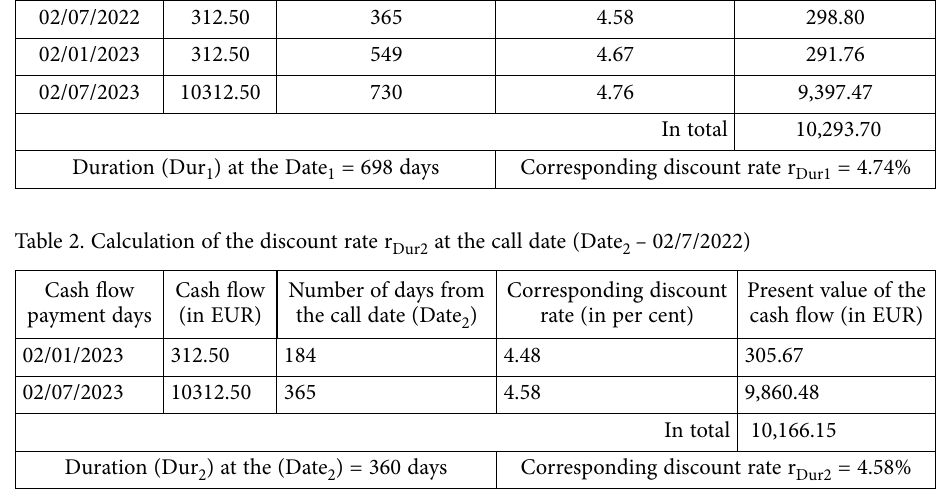
Table 1. Calculation of the discount rate r Dur1 at the call date (Date 1 – 02/07/2021) Cash flow Cash Flow payment days (in EUR)